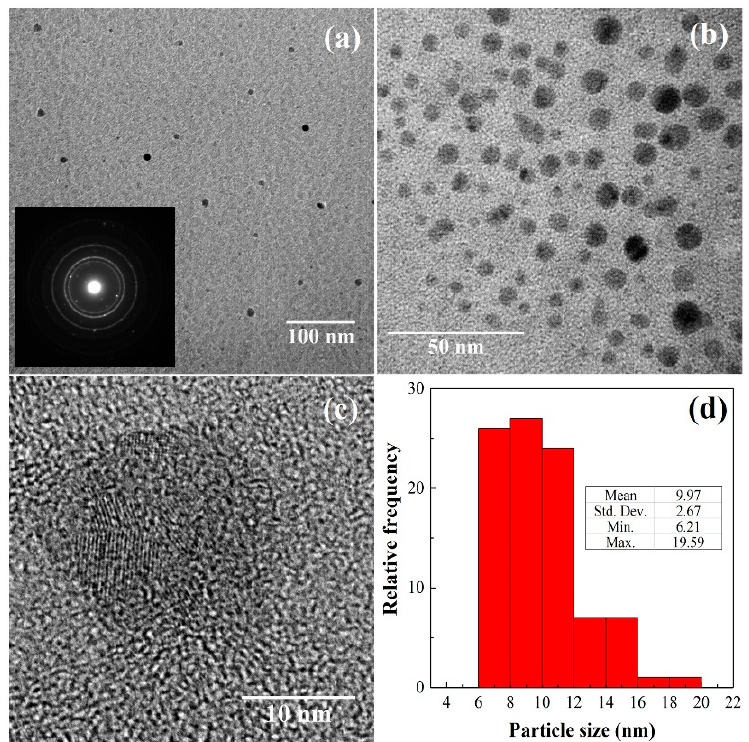
Figure 5. ( a – c ) Transmission electron microscopy (TEM) micrographs of Mo 15 S 19 prepared in linseed oil at different magnifications. The inset in ( a ) shows the selected area electron diffraction (SAED) pattern. ( d ) Histogram showing the particle size distribution.